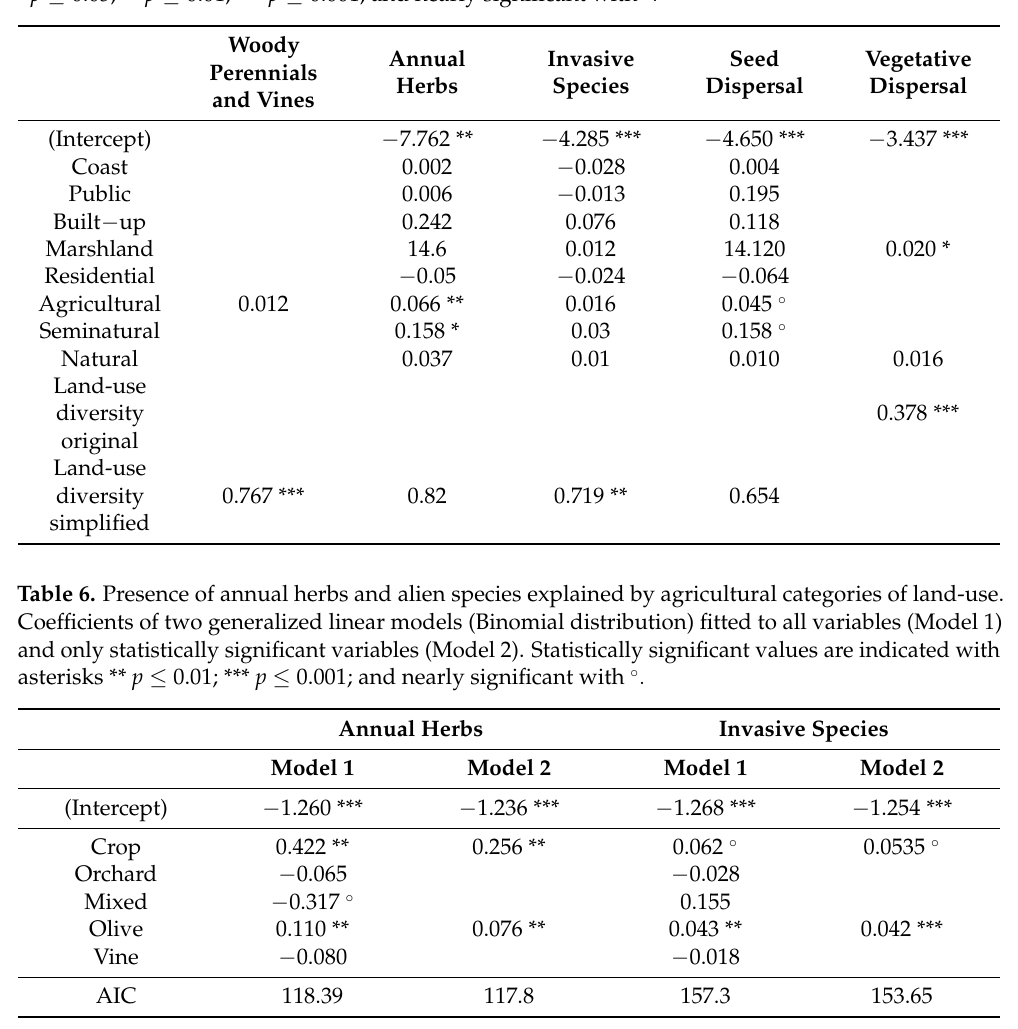
Table 5. Presence of woody perennials and vines, annual herbs, invasive species, and taxa considered based on predominant seed or vegetative dispersal explained by simplified categories of land-use and land-use diversity. Coefficients of generalized linear models (Binomial distribution) selected according to the lowest AIC value. Statistically significant values are indicated with asterisks